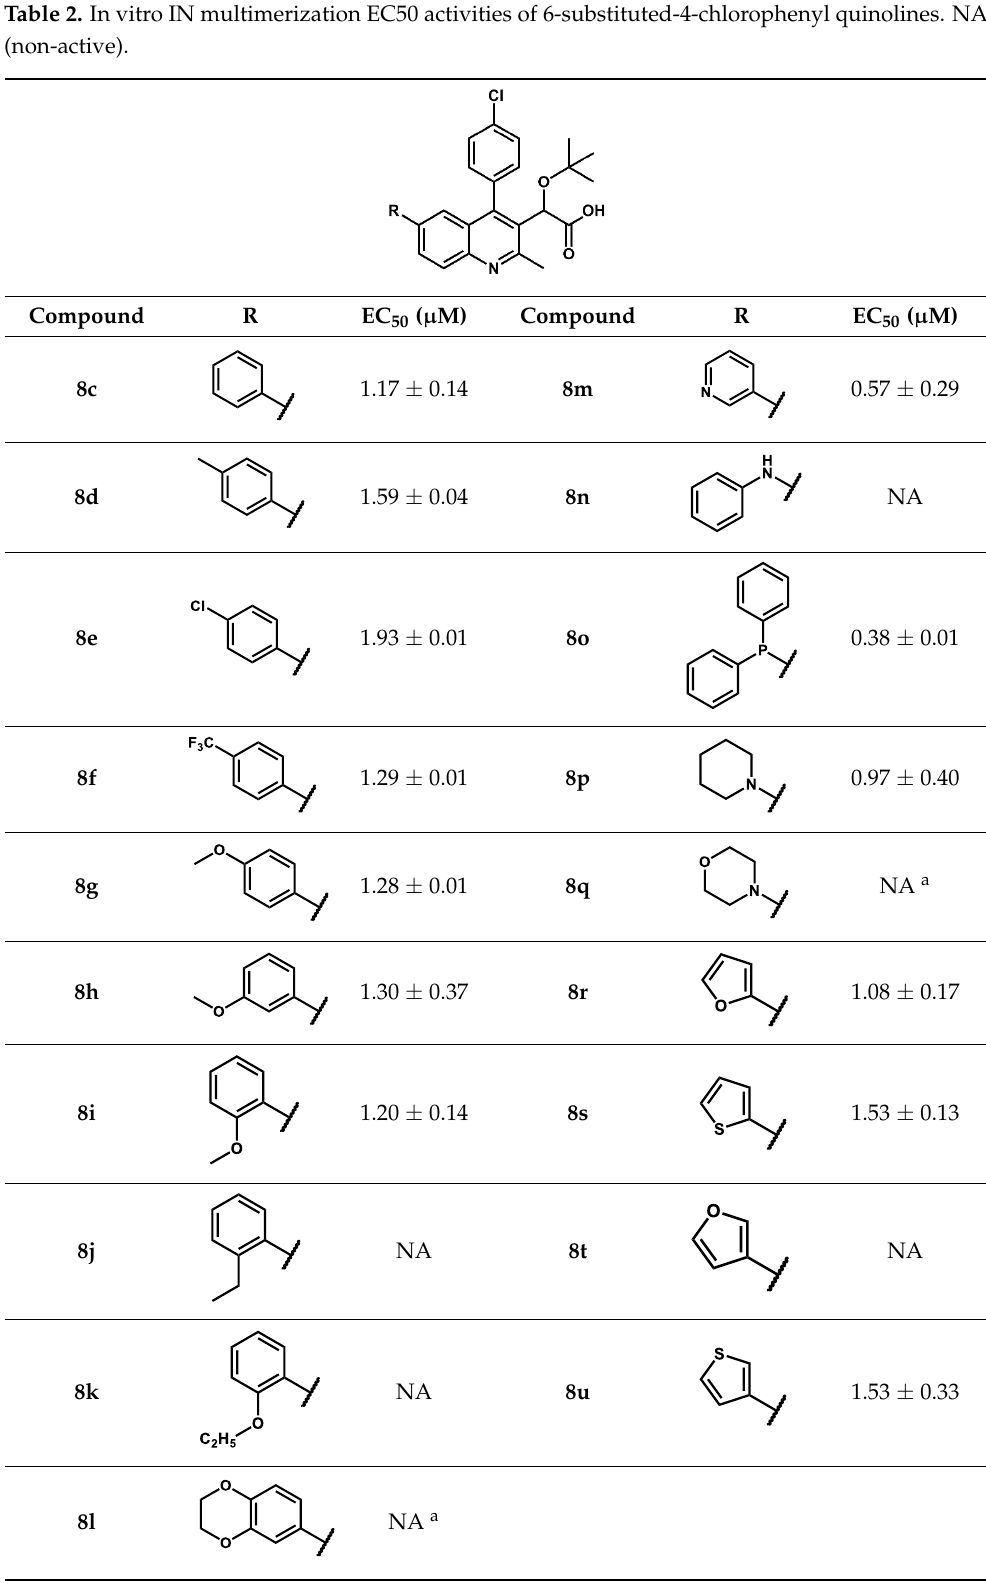
Table 2. In vitro IN multimerization EC50 activities of 6-substituted-4-chlorophenyl quinolines. NA (non-active).